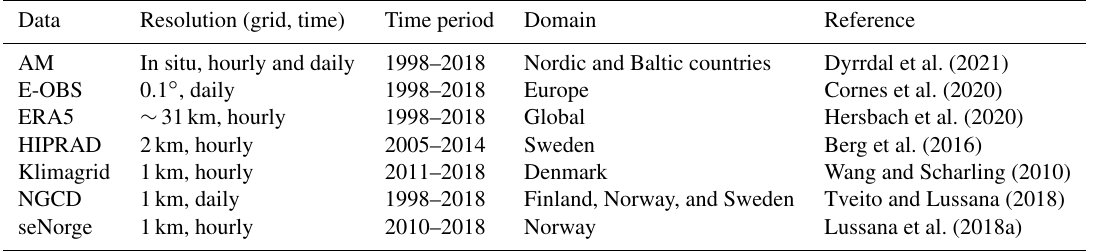
Table 1. A summary of the observational datasets that were used in the model evaluation. The time period refers to the period used in this study. AM refers to the dataset of annual maximum